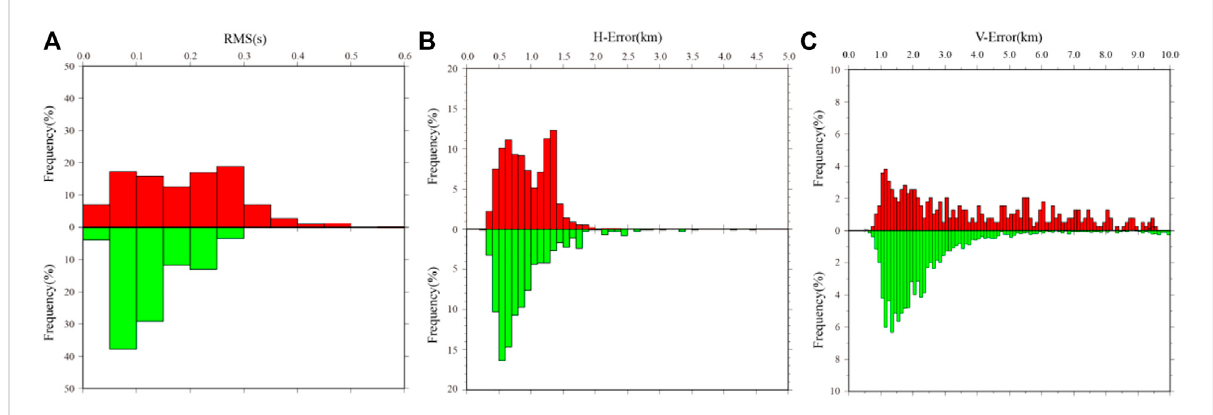
FIGURE 5 Histograms of the earthquake location (A) RMS error, (B) horizontal error, and (C) vertical error before (red) and after (green) deployment of three portable